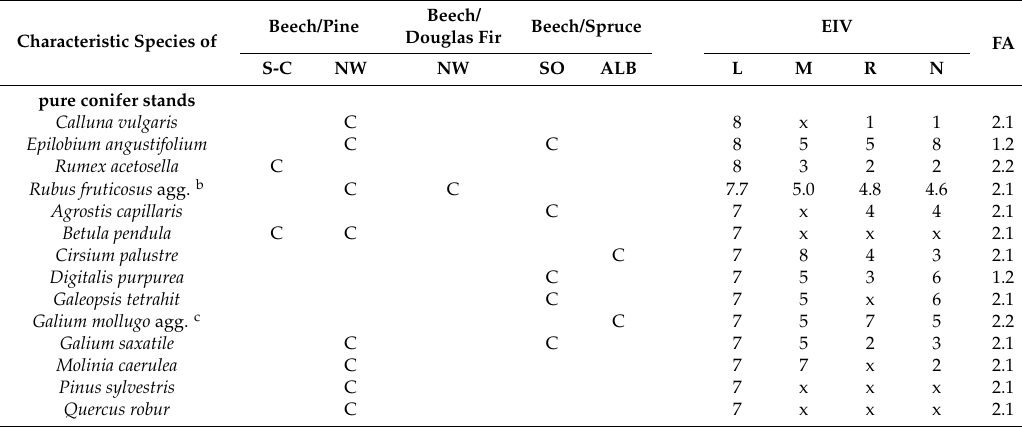
Table 4. Vascular plant species associated with pure conifer (C), pure beech (B) or mixed stands (M) in the four investigated regions based on indicator species analyses. a S-C = Schorfheide-Chorin, NW = Northwestern Germany, SO = Solling, ALB = Schwäbische Alb. Species order follows a